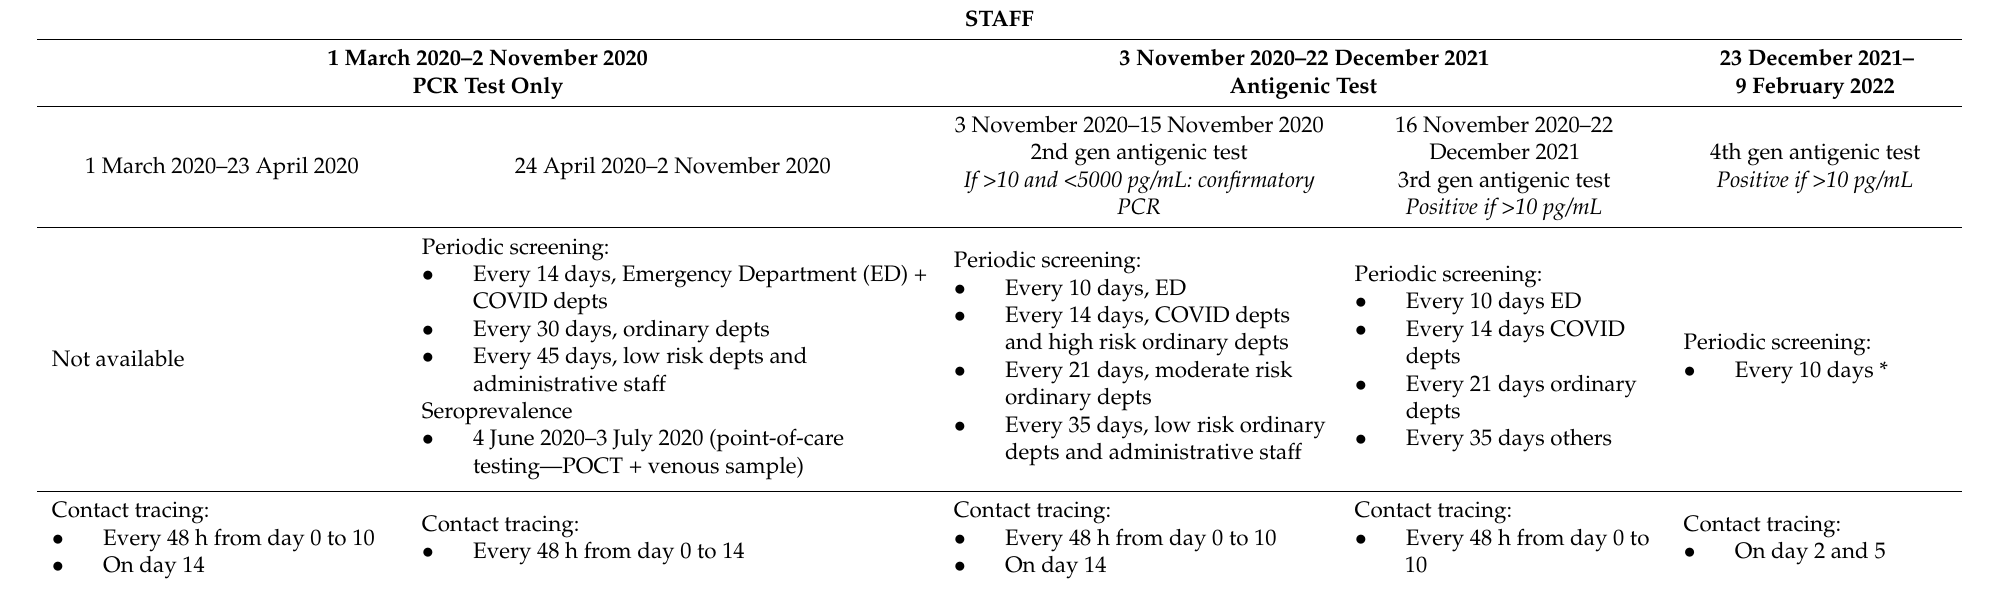
Table 1. The staff population underwent nasopharyngeal swab tests from 1 March 2020 to 9 February 2022, alongside the patients.